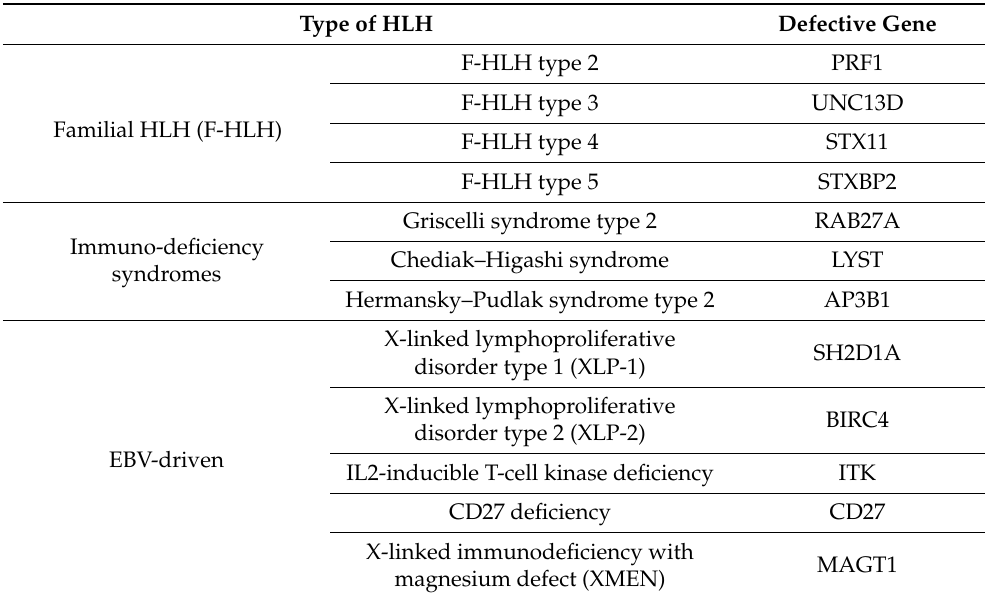
Table 4. Genetic defects associated with primary